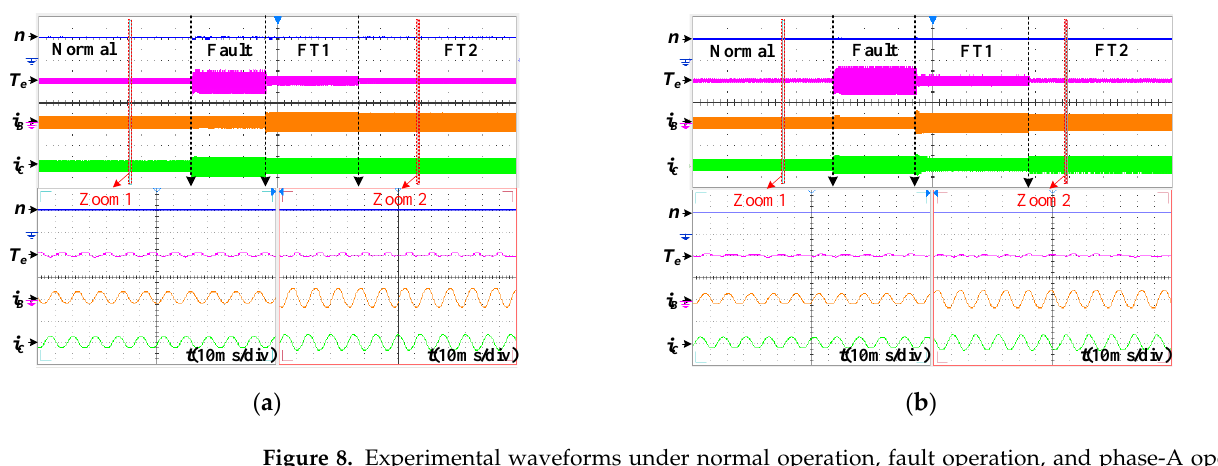
Figure 7. Dynamic responses with the changed load in healthy operation for the proposed FOC (500